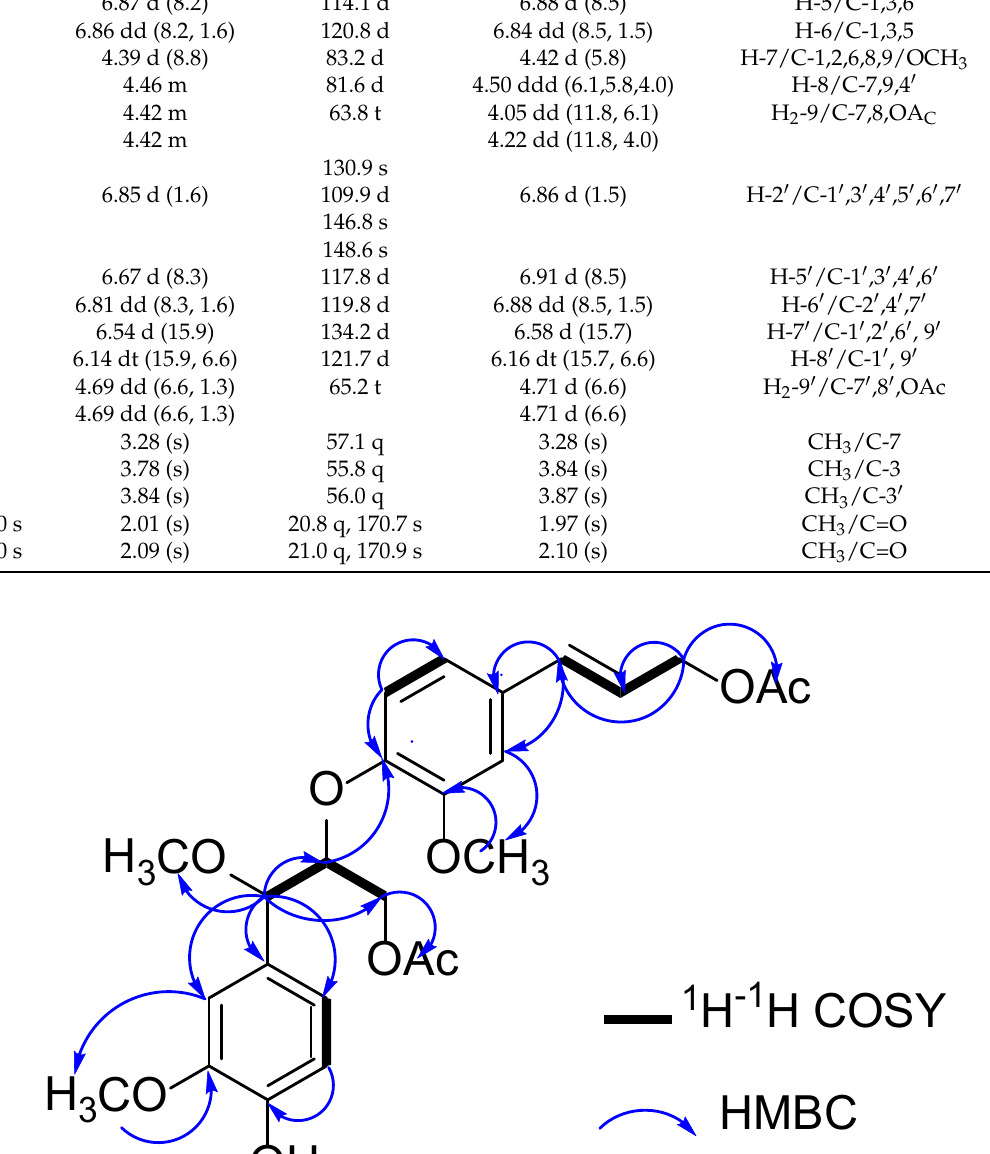
HMBC (Figure 2) correlations from H-7 to C-1/C-2/C-6/C-8/C-9/OCH 3 , H-2 to C-1/C-3/C- 6/C-7, H-5 to C-1/C-3/C-6, H-6 to C-1/C-3/C-5, H-8 to C-7/C-9 and H 2 -9 to C-7/C-8/OA C ,